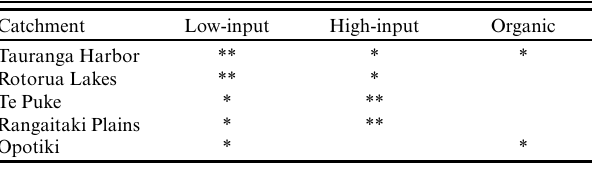
Table 4 . Distribution of farms (n = 15) participating in